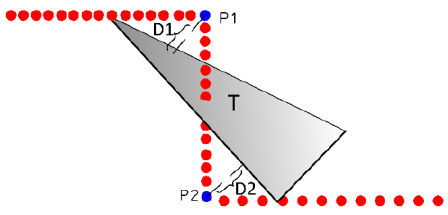
Figure 9. Triangle side